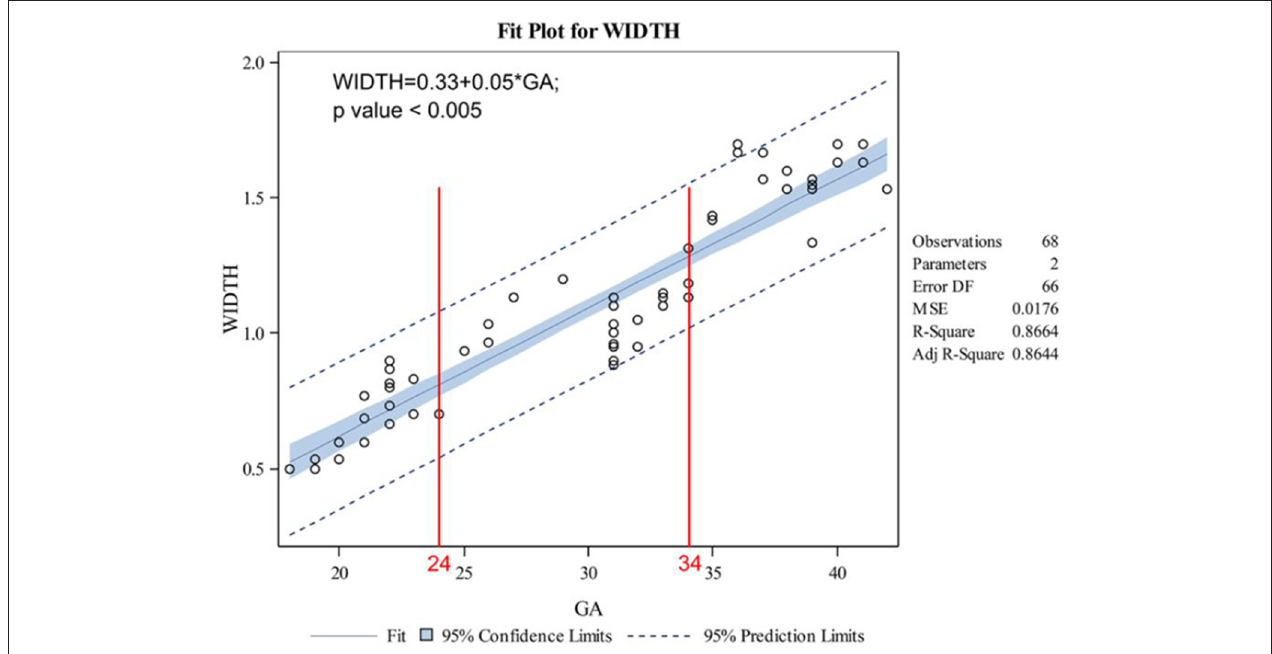
FIGURE 4 | Correlation between gestational age and acetabular width.